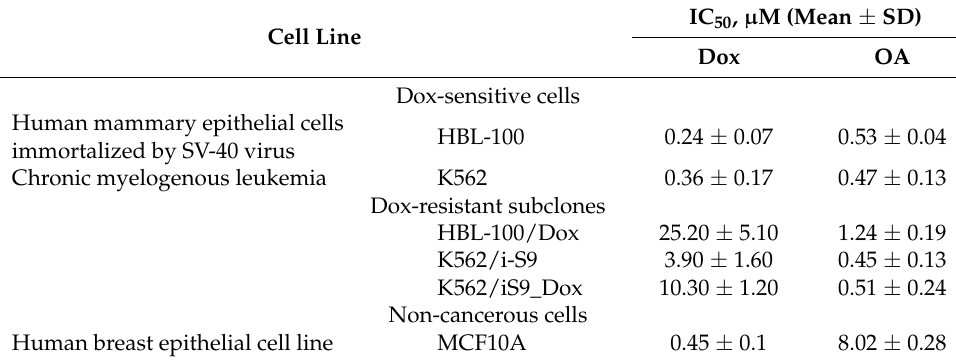
Table 1. Cytotoxicity of OA against human cancer cell lines, non-cancerous human breast epithelial cells and resistant subclones (MTT-test, 72